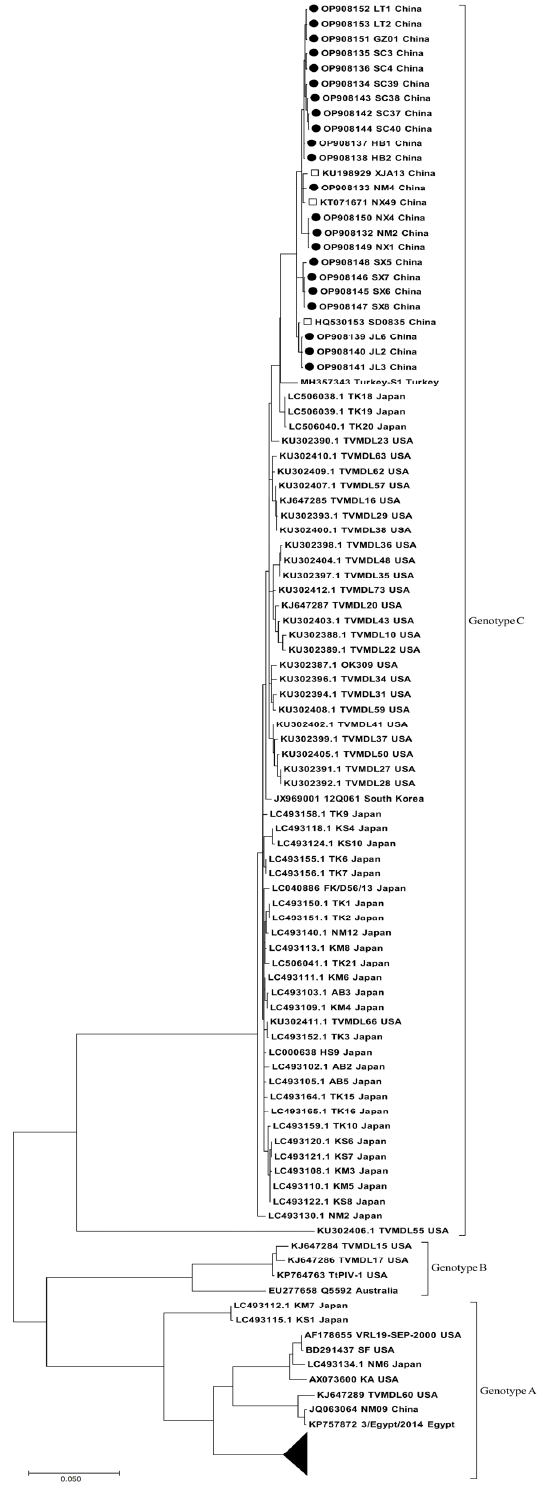
Figure 2. Phylogenetic tree based on HN gene sequences. MEGA 7.0 software was used to conduct multiple sequence alignments, and a phylogenetic tree was created using the ML method. The black circular marker sequences were obtained by amplification in this study; the black box markers are the sequences of other genotype C strains in China; the black triangle represents the set of HN sequences of BPIV3 genotype A sequences that are not shown in the phylogenetic